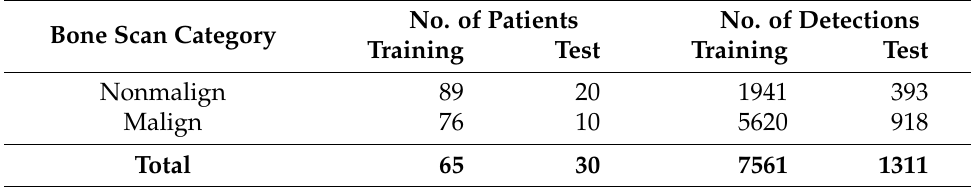
Table 2. Split of the dataset.